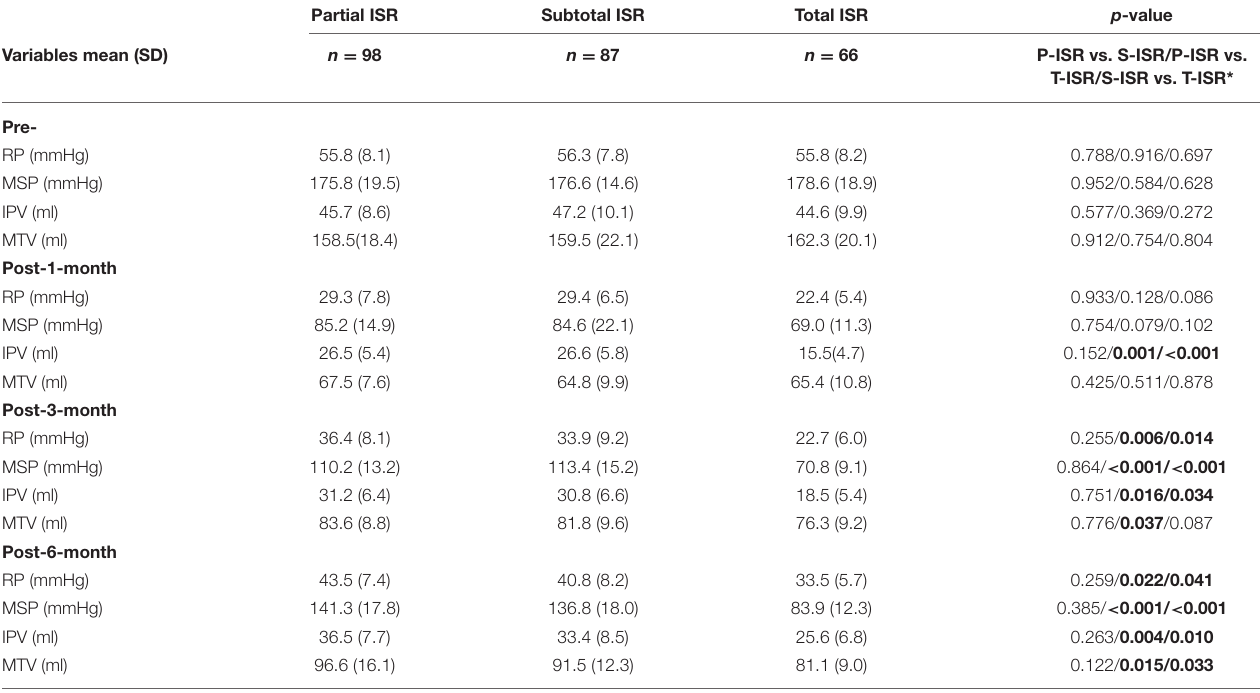
TABLE 5 | Anorectal manometric measurements after ISR. Partial ISR Subtotal ISR Total ISR